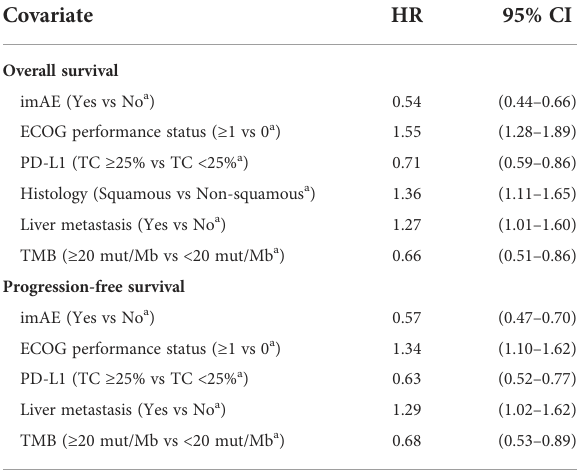
TABLE 1 Multivariate analysis for overall survival and progression- free survival in the immunotherapy arms combined. Covariate HR 95% CI Overall survival